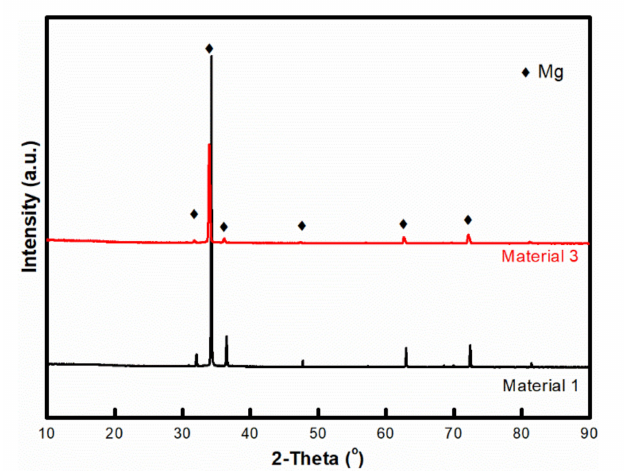
Figure 7. XRD pattern of the ARB process